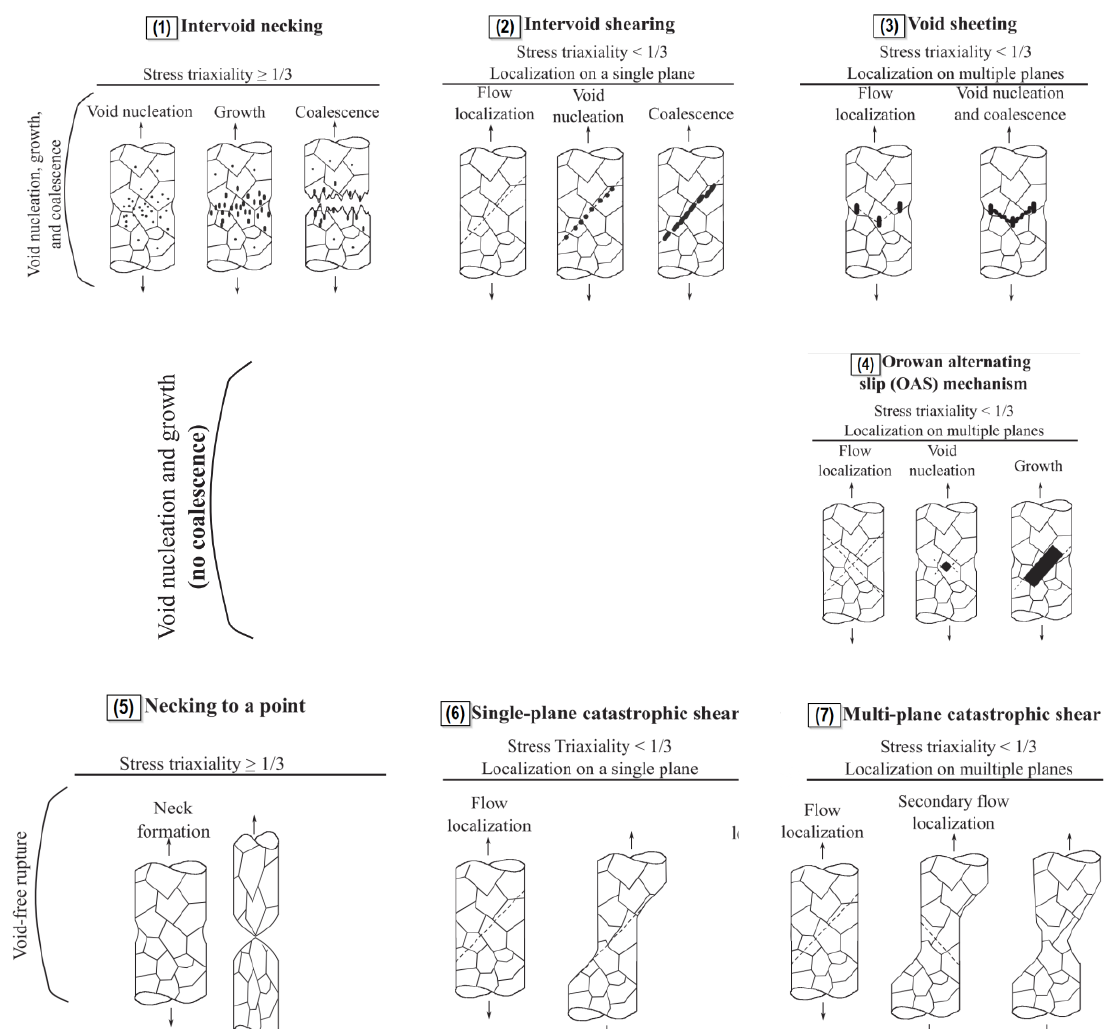
Figure 13. Types of ductile failure mechanisms: ( 1 ) Intervoid necking, ( 2 ) Intervoid shearing, ( 3 ) Void sheeting, ( 4 ) The Orowan alternating slip, ( 5 ) Necking to a point, ( 6 ) Single-plane catastrophic shear, ( 7 ) Multiplane catastrophic shear [109].